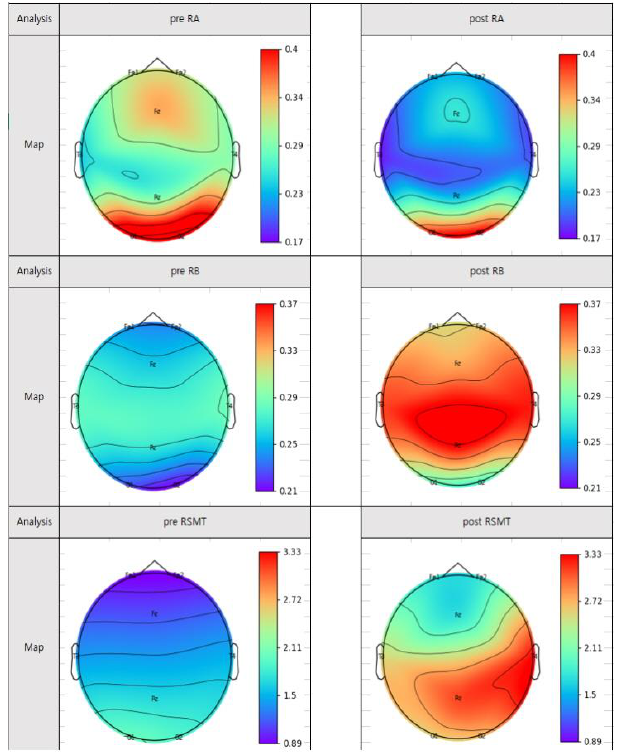
Figure 5. VR group EEG mapping. Table 4. EEG descriptive